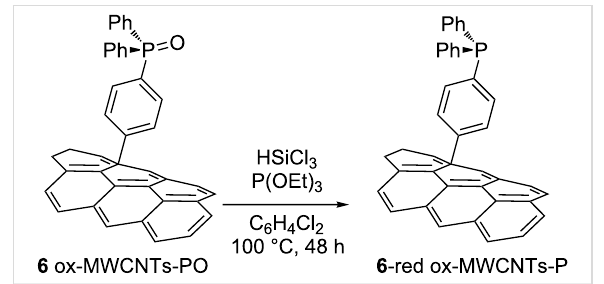
phosphorus-phosphorus, trichlorosilane mediated oxygen